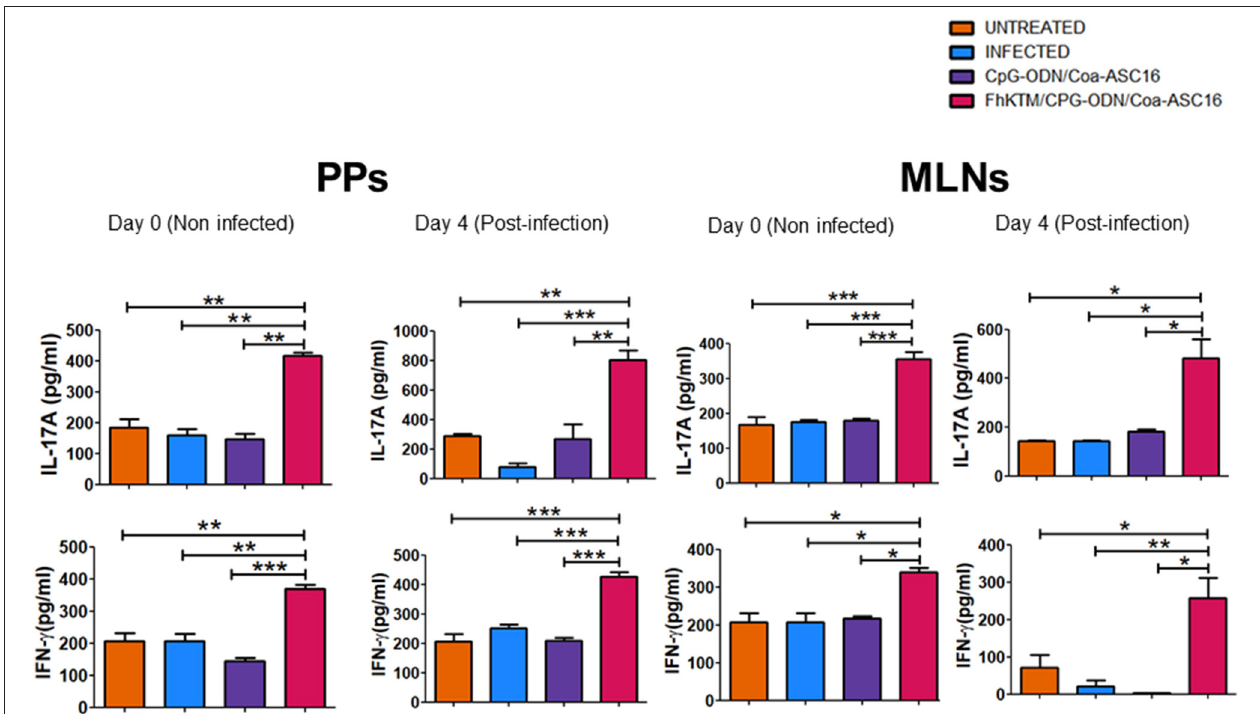
FIGURE 5 | KTM/CpG-ODN/Coa-ASC immunized mice showed increased production of IFN- γ and IL-17A in supernatants from PPs and MLNs. Cell suspensions from PPs and MLNs from treated mice at day 0 (uninfected) and 4 dpi were cultured for 3 days with FhKTM. The IFN- γ and IL-17A were measured in the culture supernatants by ELISA test. Results are shown as mean ± SD and levels of significance as indicated by p -values, were assessed by one-way ANOVA and Tukey’s multiple comparison tests * p < 0.05; ** p < 0.01; *** p <